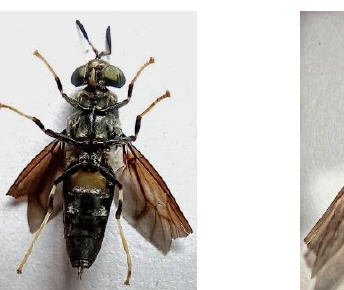
Figure 9: Ventral view of Black soldier fly captured from the site of incidence